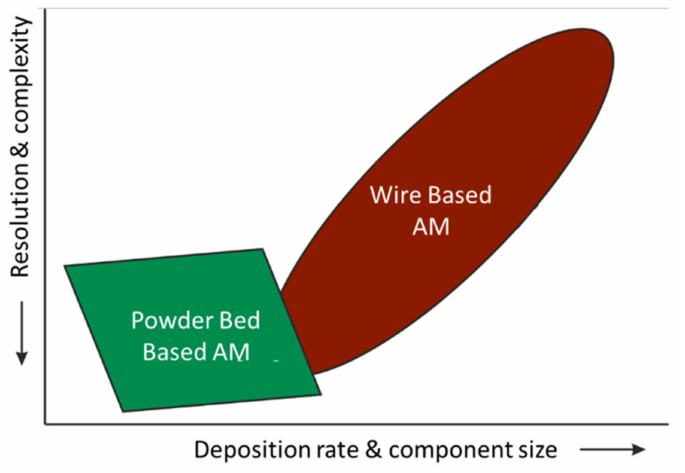
Figure 1. Comparison between wire-based and powder bed-based additive manufacturing [1].